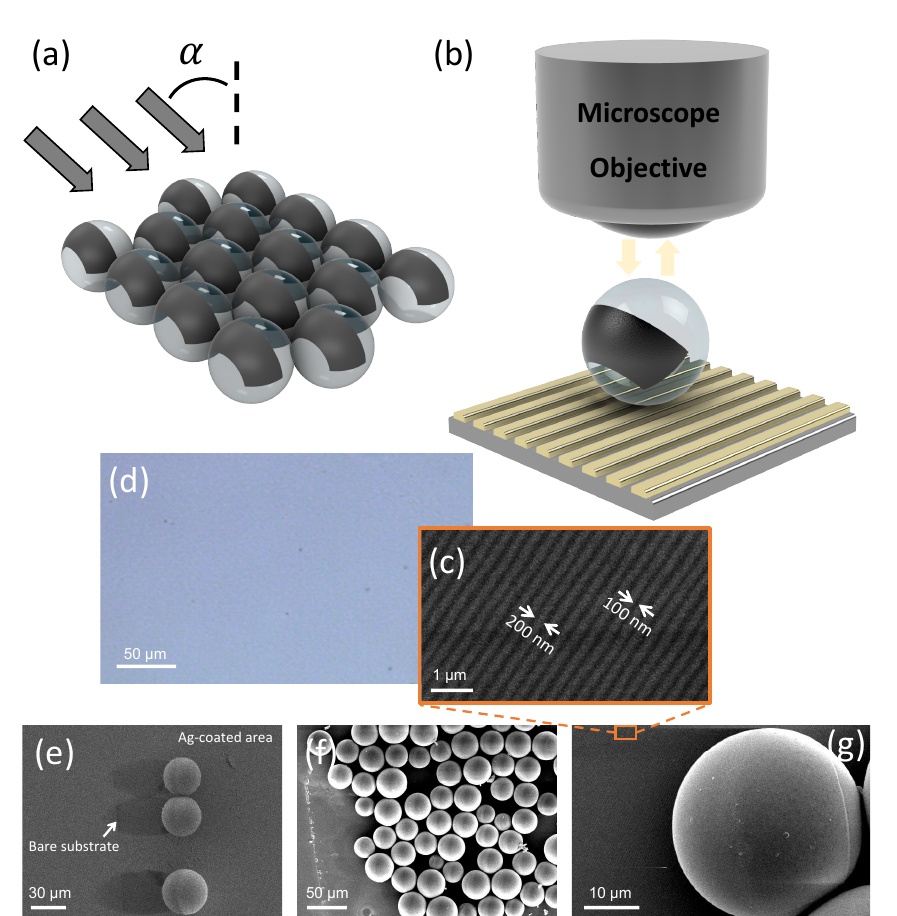
Figure 1. ( a ) Fabrication of patchy BTG (p-BTG) particle by glancing angle deposition method; ( b ) experimental setup of super-resolution imaging with p-BTG lens; ( c ) SEM image and ( d ) OM image of BD substrate (lines not resolved); ( e , f ) SEM images of p-BTG particle after Ag deposition; ( g ) SEM image of p-BTG particle transferred on BD